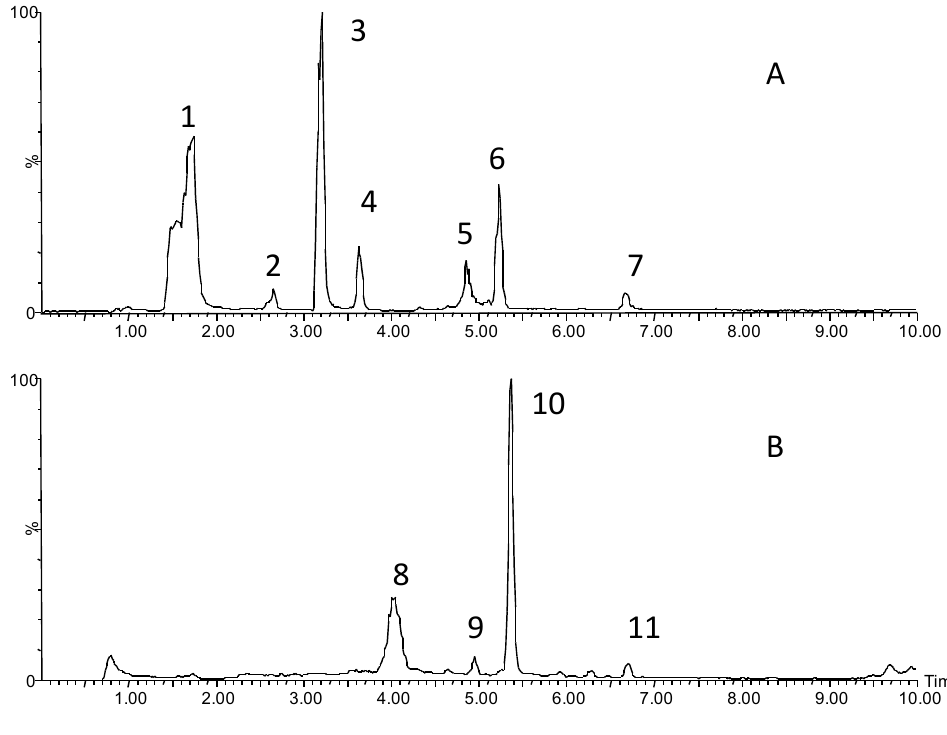
Figure 4. UPLC-MS total Ion chromatographic profile of Chinese sumac: ( A ) electrospray ion source (ESI) operating in negative mode; ( B ) ESI operating in positive